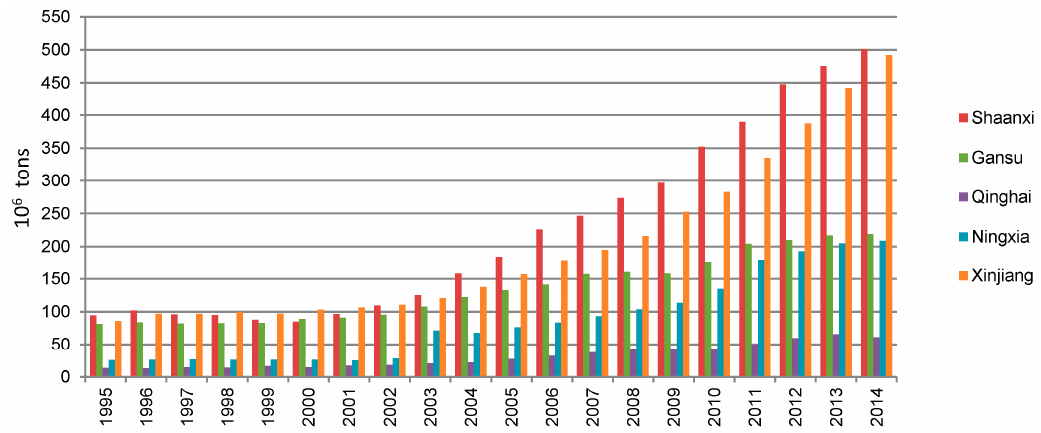
Figure 3. Changes in CO 2 emissions in five provinces.